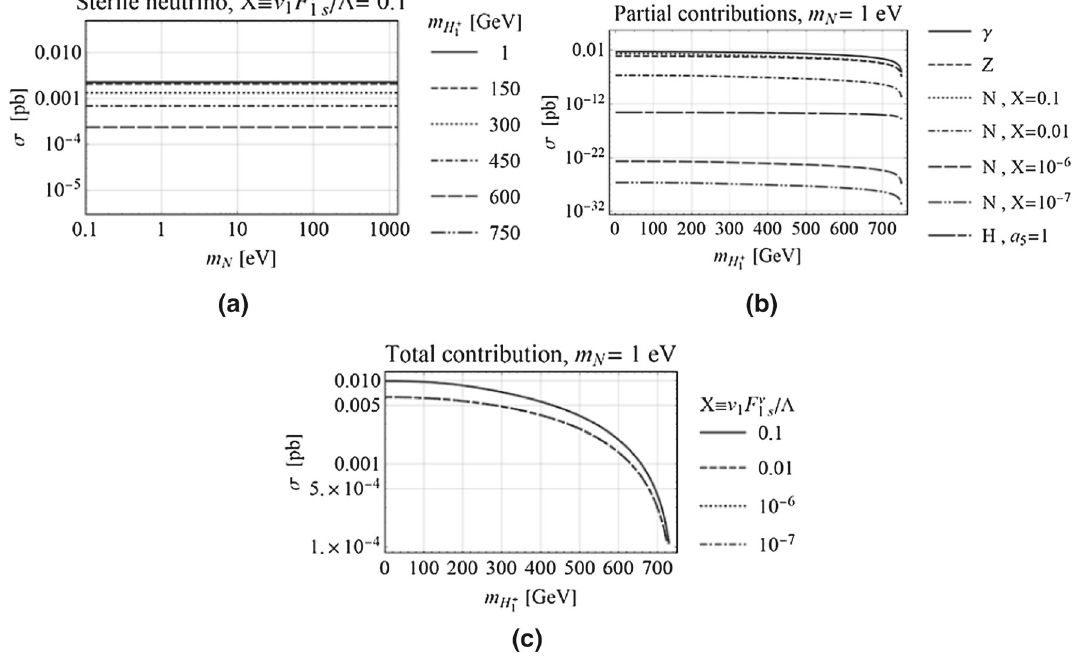
√ H − s = cross section with scalar. b The partial contribution to the cross section as a function of 1 1 the charged scalar mass. c The total cross section as a function of the charged scalar